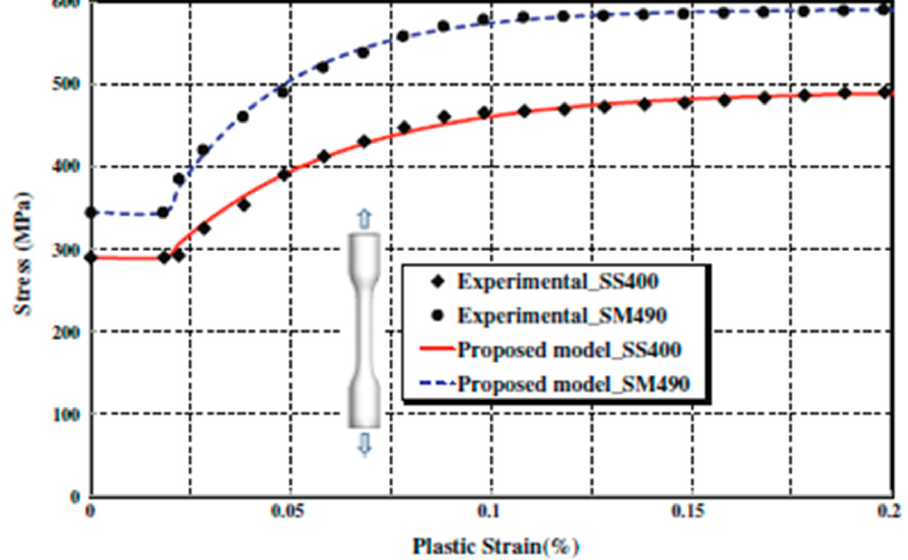
Figure 1. Stress–strain curves of SS400 and SM490 [50].